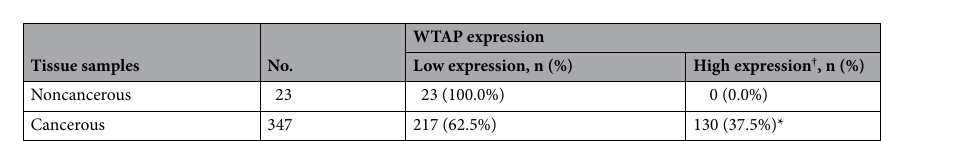
Table 1. WTAP expression in breast tissue specimens. † High WTAP expression was defined as a nuclear staining intensity of positive cancer cells of 3 13 . * P < 0.05 vs normal breast tissue.